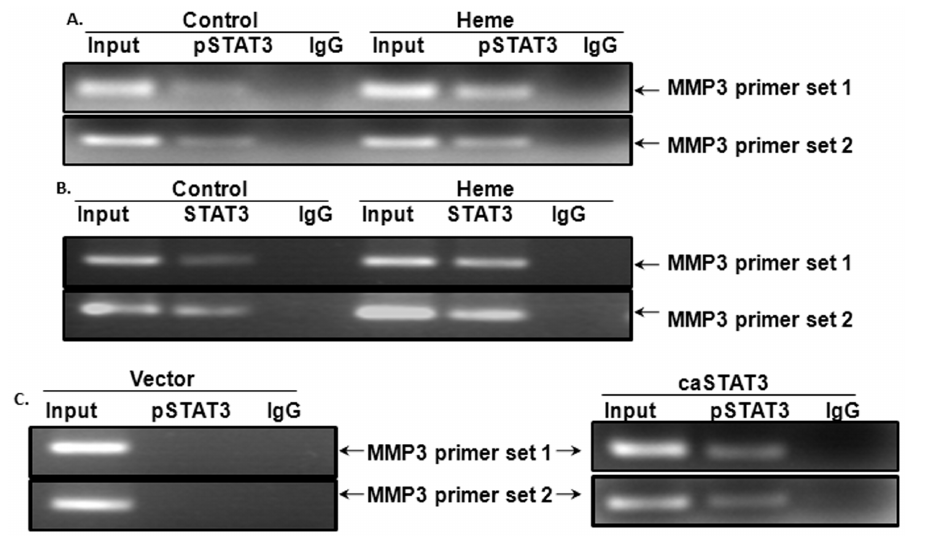
Figure 4. Tyrosine-phosphorylated STAT3 binds the MMP3 promoters in HBVEC cells. In order to determine whether STAT3 is the nuclear protein that binds to the MMP3 promoter, we conducted a ChIP analysis in Heme-treated and -untreated HBVEC cells. As shown in Figure 4A, anti- phopho-STAT3 (Tyr705) antibodies immunoprecipitated MMP3 promoter. A stronger signal was obtained from chromatin of Heme-stimulated HBVEC cells. An anti-STAT3 antibody also immunoprecipitated MMP3 promoter, more strong similar signal was observed from chromatin of